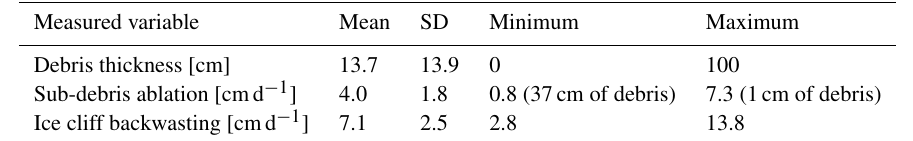
Table 2. Statistics of debris- and melt-related in situ measurements for Kennicott Glacier.